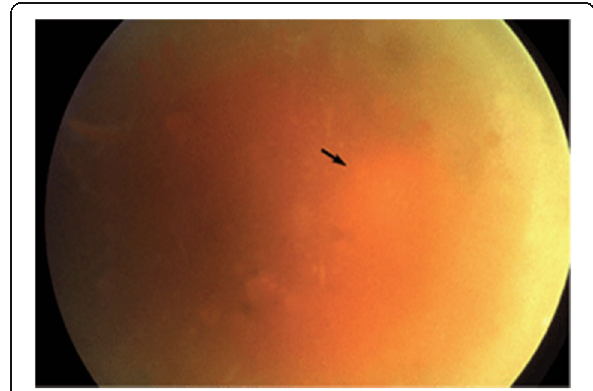
Fig. 4 Toxocara endophthalmitis with extensive vitritis obfuscates fundus details as the optic disc (arrow) is hardly visible (Singh et al.